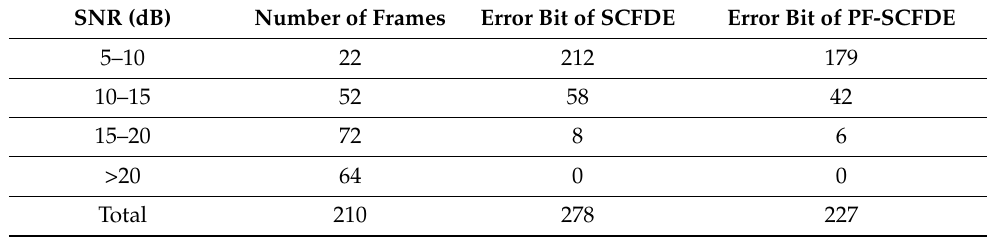
Table 3. Number of error bits of received signal frames in different received